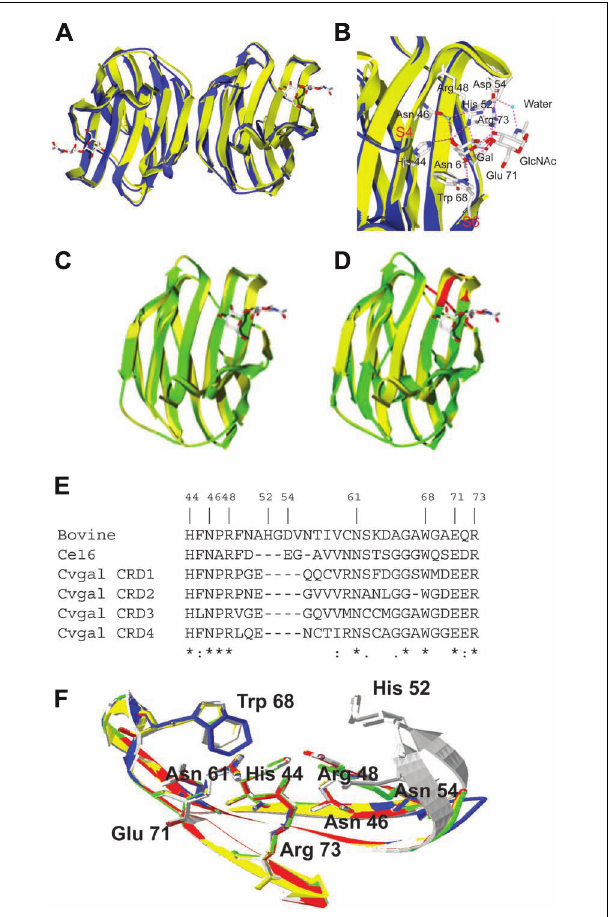
FIGURE 4 | Structures of bovine galectin-1 and Bufo arenarum galectin-1 like protein. (A) The ribbon diagram shows the overlap of the toad ( B. arenarum ) galectin-1 like protein (blue, PDB 1GAN) and bovine ( Bos taurus ) galectin-1 (yellow, PDB 1slt) in complex with LacNAc (stick representation). (B) Carbohydrate-binding sites of B. arenarum galectin-1 like protein (blue) and bovine galectin-1 (yellow).The interactions of